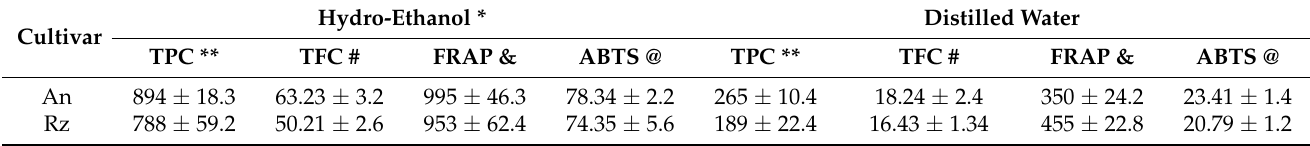
Table 2. Conventional hydro-ethanol and water extraction results for the date palm fruit cultivars under investigation; Anbara (An) and Reziz (Rz). The four different “responses” were analyzed; total phenolic content (TPC), total flavonoid content (TFC), ferric reducing antioxidant power assay (FRAP), and ABTS scavenging effect (ABTS). Other “factors” of the WAE, such as “rotation” or “temperature”, were not applied, and the “time” factor was increased to 12